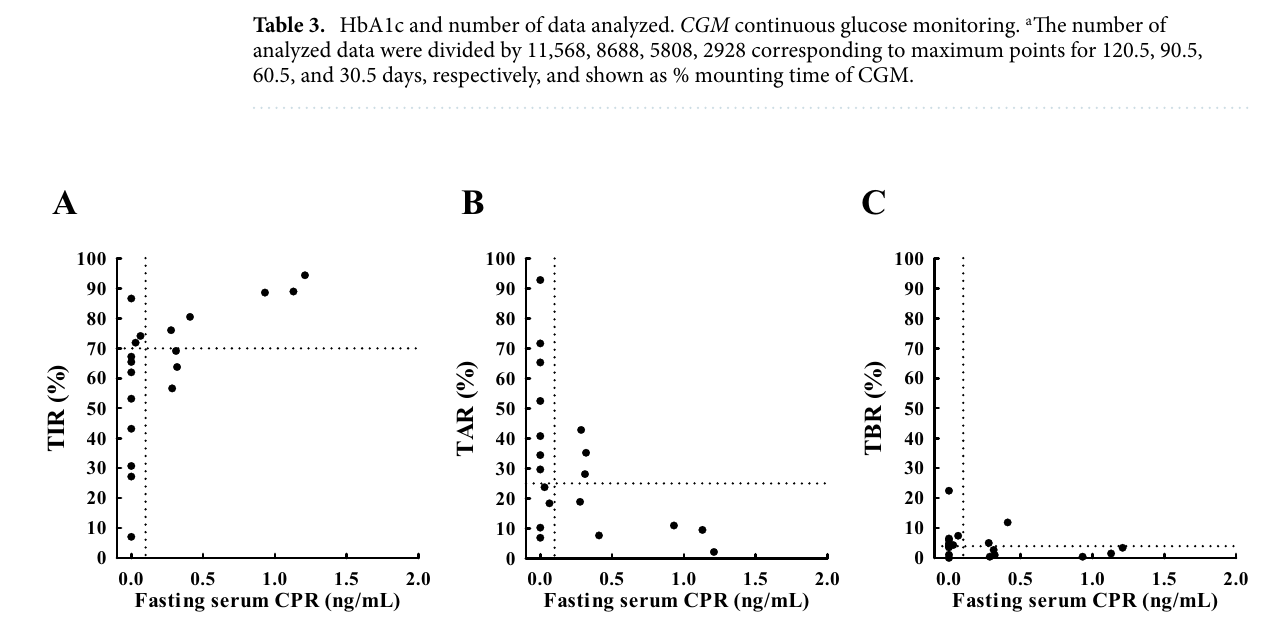
Figure 4. Scatterplot indicating the relationship between fasting serum CPR (x-axis) and CGM-related metrics (TIR ( A ), TAR ( B ), and TBR ( C ); y-axis) measured within 120 days from baseline. The dotted horizontal lines represent a TIR of 70% ( A ), a TAR of 25% ( B ), and a TBR of 4% ( C ). The dotted vertical line represents a fasting serum CPR of 0.1 ng/mL. TIR time in range (glucose 70–180 mg/dL), TAR time above range (glucose ≥ 181 mg/ dL), TBR time below range (glucose ≤ 69